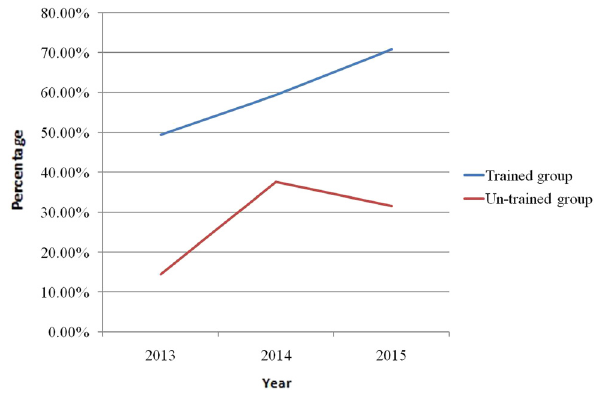
Figure 2: The rate ofbone turnovermarker test inthe patientswith hip fracture intrained group and untrained group between 2013 and 2015.